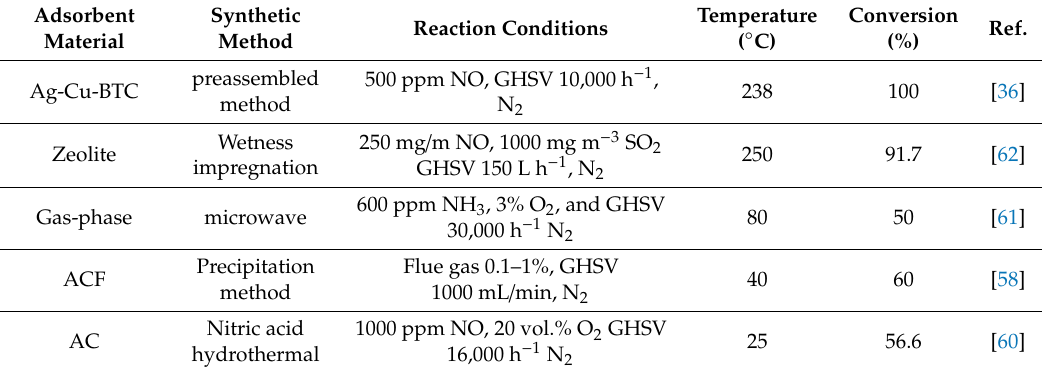
Table 1. E ff ect of di ff erent adsorption materials on NO conversion.